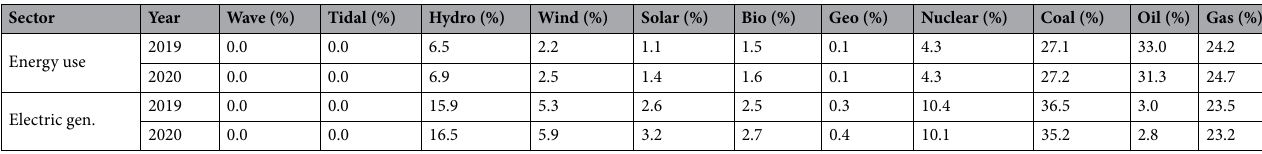
Table 2. Calculated shares of the world energy use 21 and electric power generation 22 in 2019 and 2020.